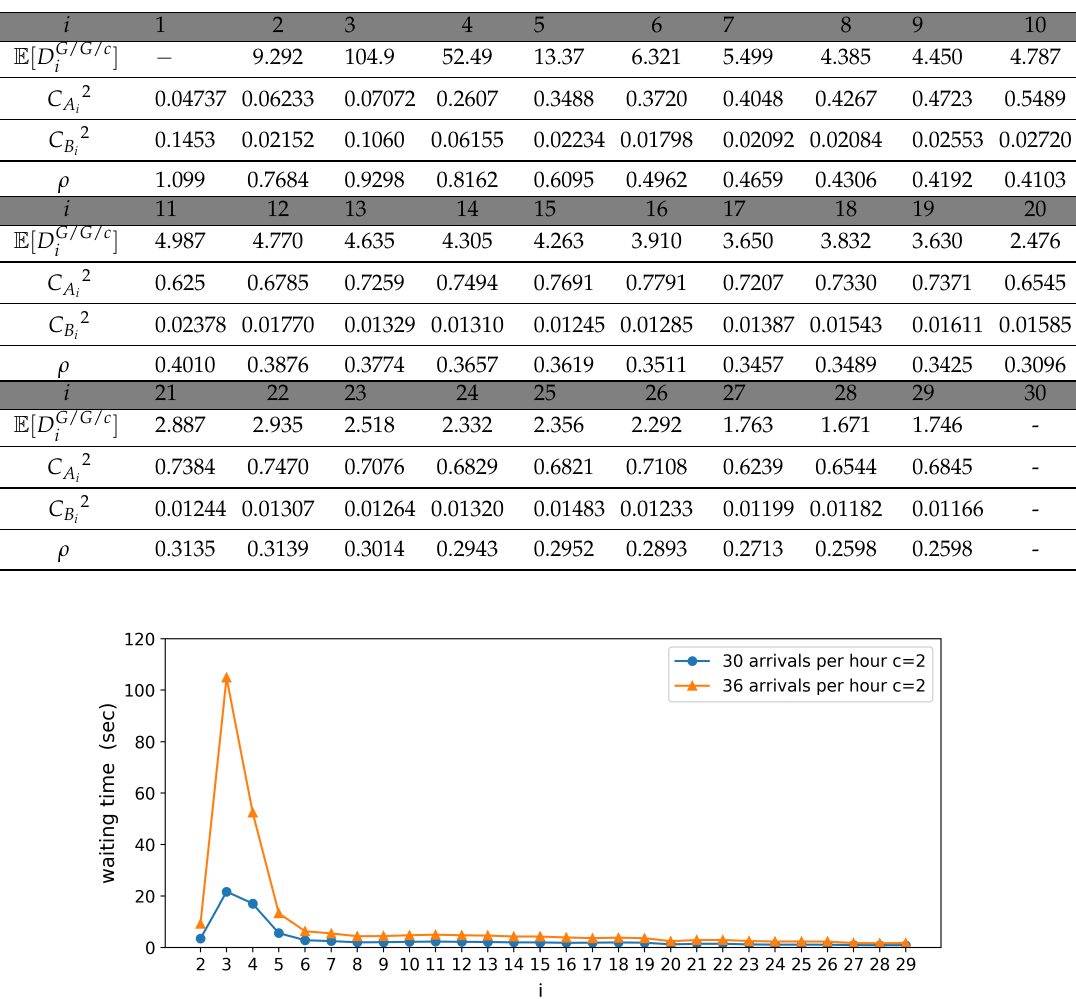
Table 4. Aircraft arrival delay and parameters of the G / G / c model, c = 2, arrival rate = 36 aircraft per hour.